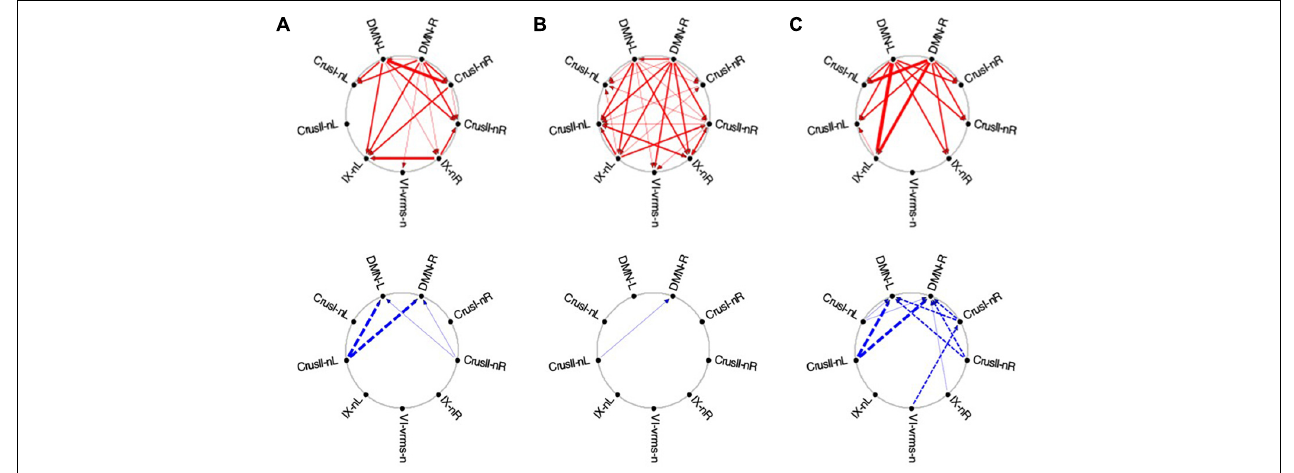
FIGURE 12 | Average Granger causal connectivity for Visualization in the task-negative network (shown in the same format and significance criteria as for Figure 10 ). Upper row: Congruent causal influences within the network of cerebellar ROIs and the cortical DMN. Lower row: Inverse causal influences . The Granger Causal Connectivity demonstrates rapid network reorganization over the visualization task repeats. The DMN in strongly involved bilaterally, sending congruent GC influences to these task-negative ROIs during all three repeats, and receiving weak inverse influences from the Crus ROIs.